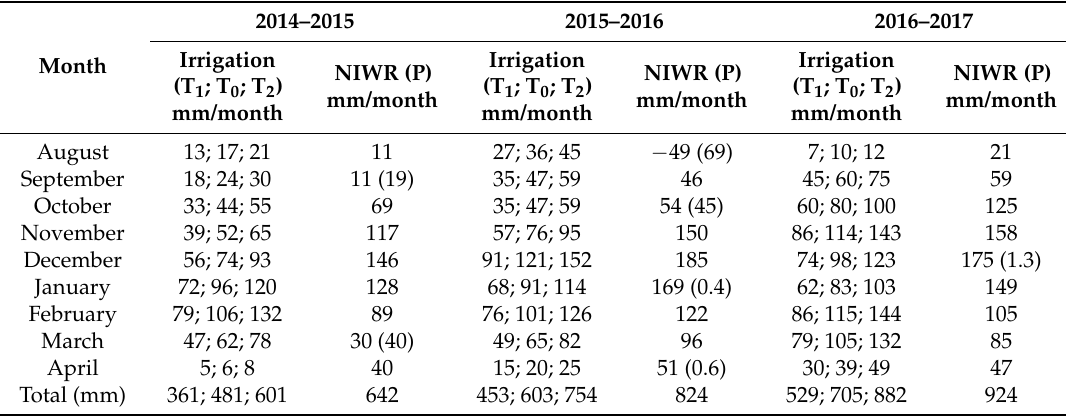
Table 2. Monthly accumulated values of the net irrigation water requirements (NIWR), precipitation (P), and irrigation applied by the farmer for the whole field (T 0 ) and the treatments established (T 1 and T 2